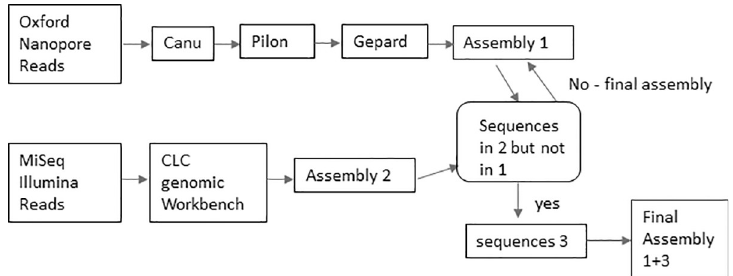
Fig 1. Schematic representation of the analysis pipeline used in this study for assembly and polishing of the MinION sequencing output.